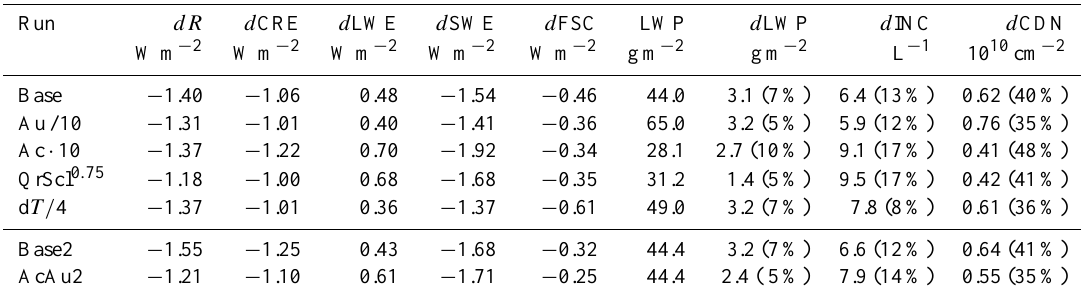
Table 3. Table of radiative property changes (year 2000–1850) from simulations. Illustrated are change in top of atmosphere radiative fluxes ( R ), net cloud radiative effect (CRE) as well as the long-wave effect (LWE) and shortwave effect (SWE) components, the change in clear-sky shortwave radiation (FSC), ice water path (IWP) and year 2000 LWP. Also shown are changes to in-cloud ice number concentration (INC) and column liquid drop number